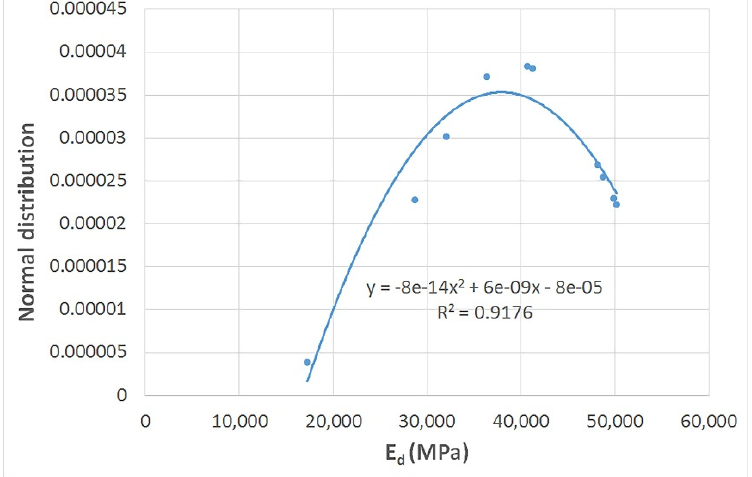
Figure 10. Gauss distribution of elastic dynamic modulus of stones.